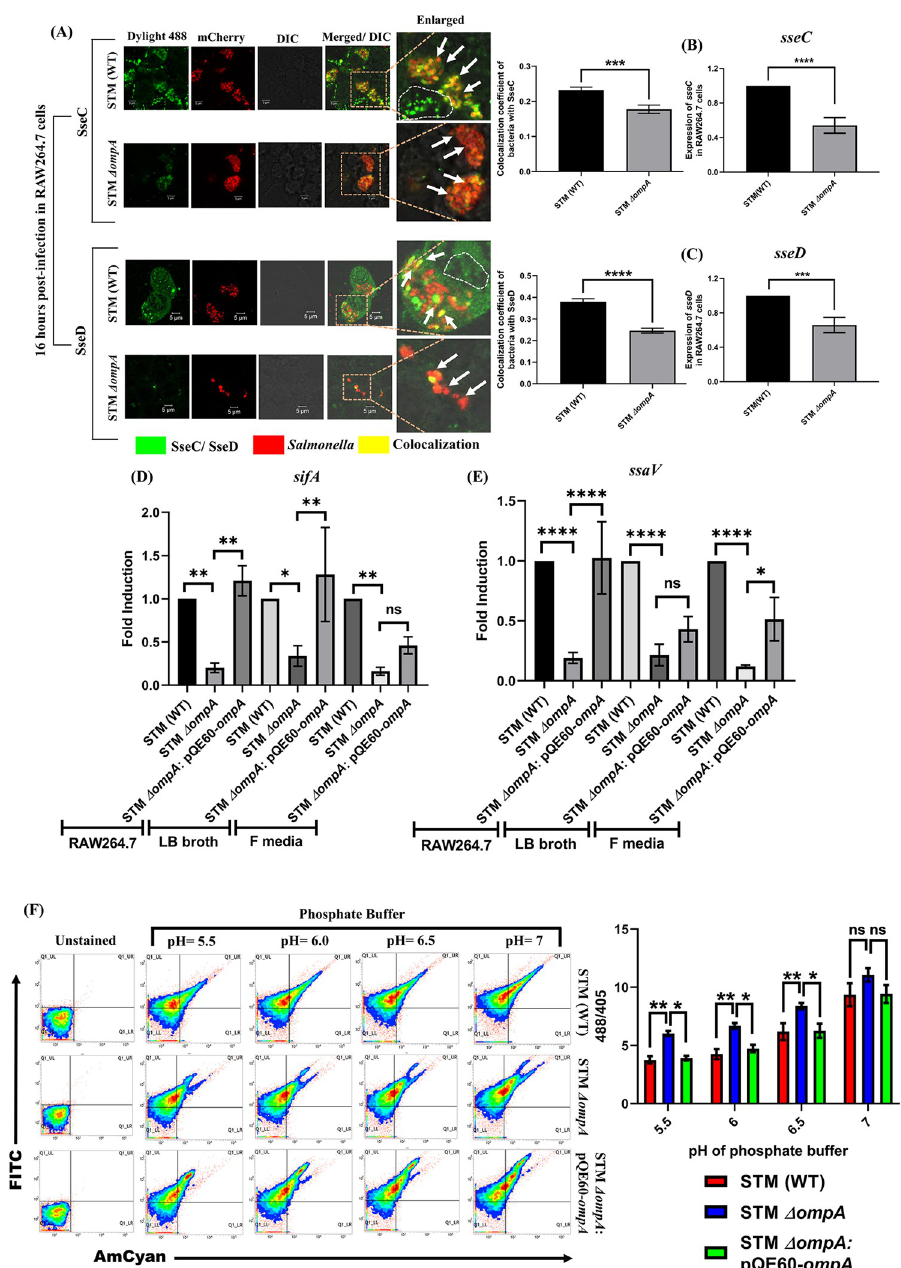
Fig 2. Deficiency of OmpA downregulates the expression of SPI-2 effector proteins in Salmonella . (A) Representative image of SseC/ SseD recruitment on STM (WT) and Δ ompA expressing RFP (MOI 20) in RAW264.7 cells. The colocalization coefficient of bacteria with SseC and SseD were represented as vertical bar graphs. Scale bar = 5 μ m, (n = 50, N = 3). Quantification of the expression of (B) sseC and (C) sseD in STM (WT) and Δ ompA growing intracellularly in RAW264.7 cells by RT-qPCR (n = 3, N = 3). The expression profile of (D) sifA and (E) ssaV in STM (WT), Δ ompA , and Δ ompA -pQE60- ompA growing in RAW264.7 cells, LB broth, and acidic F media, respectively (n = 3, N = 3). (F) Studying the intracellular acidification of BCECF-AM stained STM (WT), Δ ompA , and Δ ompA : pQE60- ompA in phosphate buffer of pH 5.5, 6, 6.5, and 7, respectively, using 20 μ M of BCECF-AM by flow cytometry. The ratio of BCECF-AM (MFI) at 488 and 405 nm were represented as a vertical bar graph (n = 4, N = 3). Data are represented as mean ± SEM. (P) � < 0.05, (P) �� < 0.005, (P) ��� < 0.0005, (P) ���� < 0.0001, ns = non- significant, (Unpaired stuedent’s t test in A, B, C and one-way ANOVA in D, E, F) .